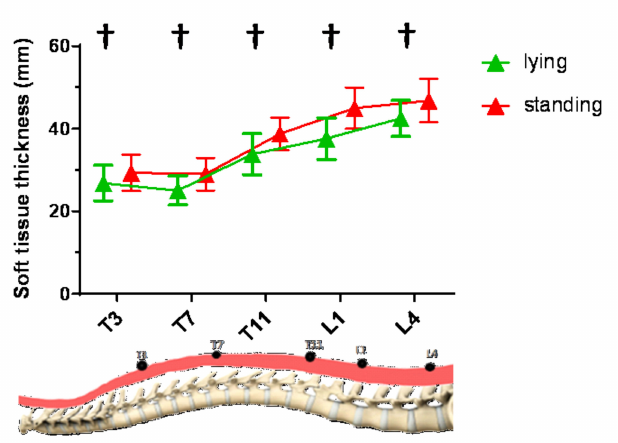
Figure 6. The soft tissue thickness at di ff erent levels in lying and standing postures among subjects ( n = 64). † Significant di ff erences existed in posture.